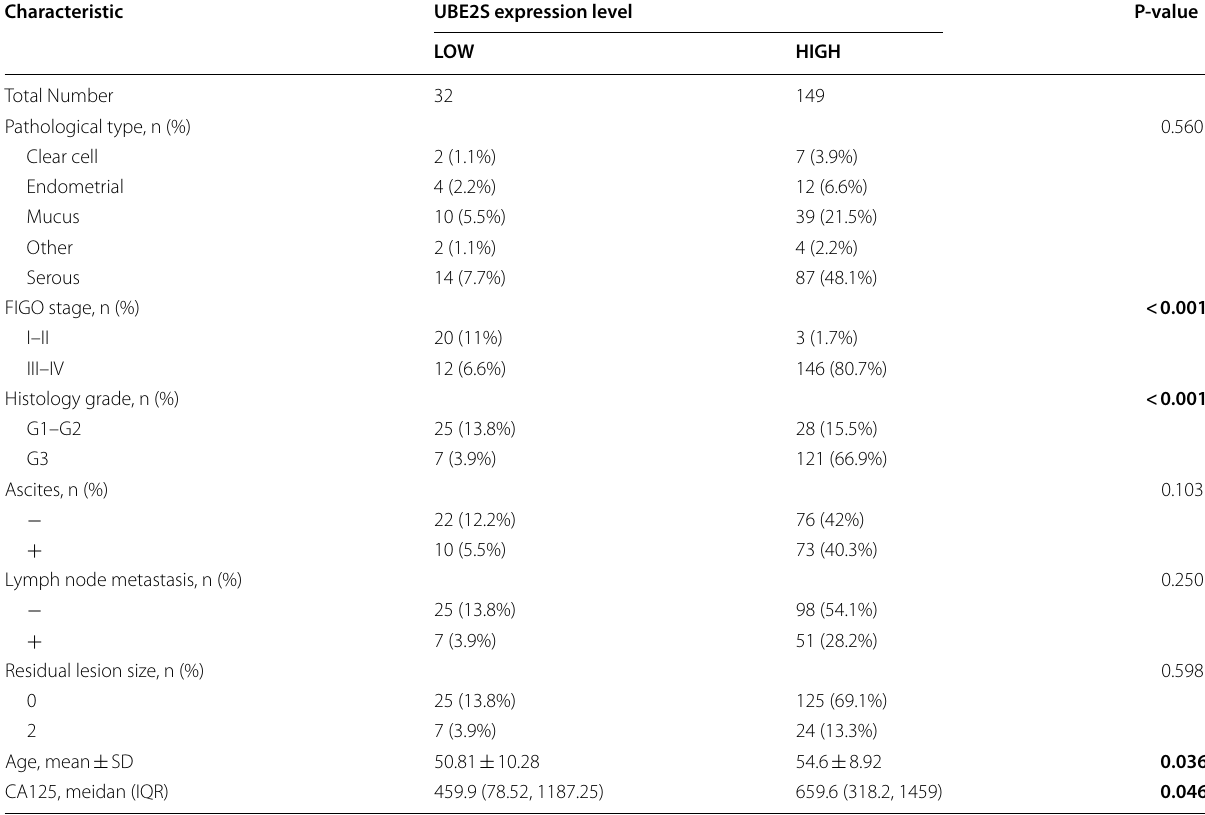
Table 1 Baseline data sheet of UBE2S in patients with ovarian cancer